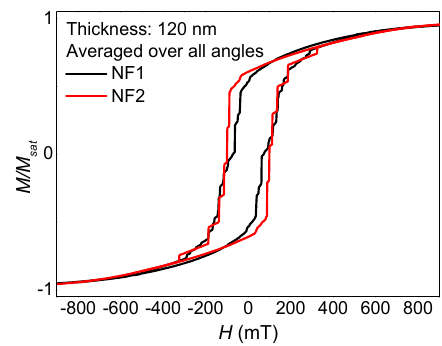
Figure 10. Angle dependence of the longitudinal and transverse hysteresis loops simulated for sample NF2 with a thickness of 120